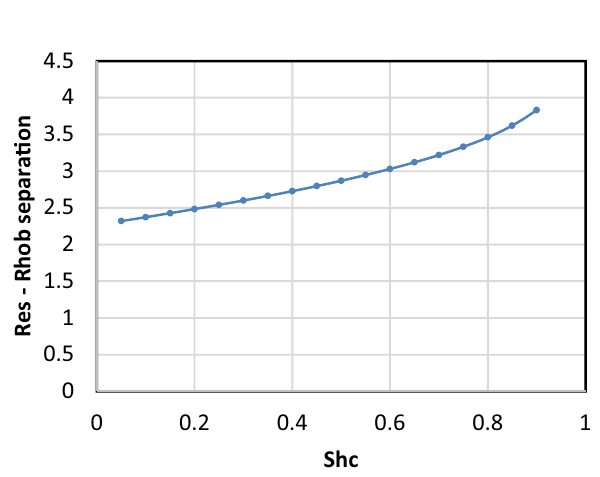
Fig. 18 S hc versus separation for